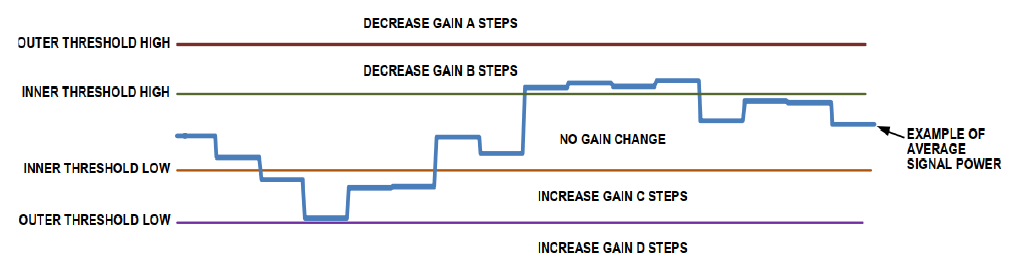
Figure 7. Slow attack AGC mode function example and control parameters.